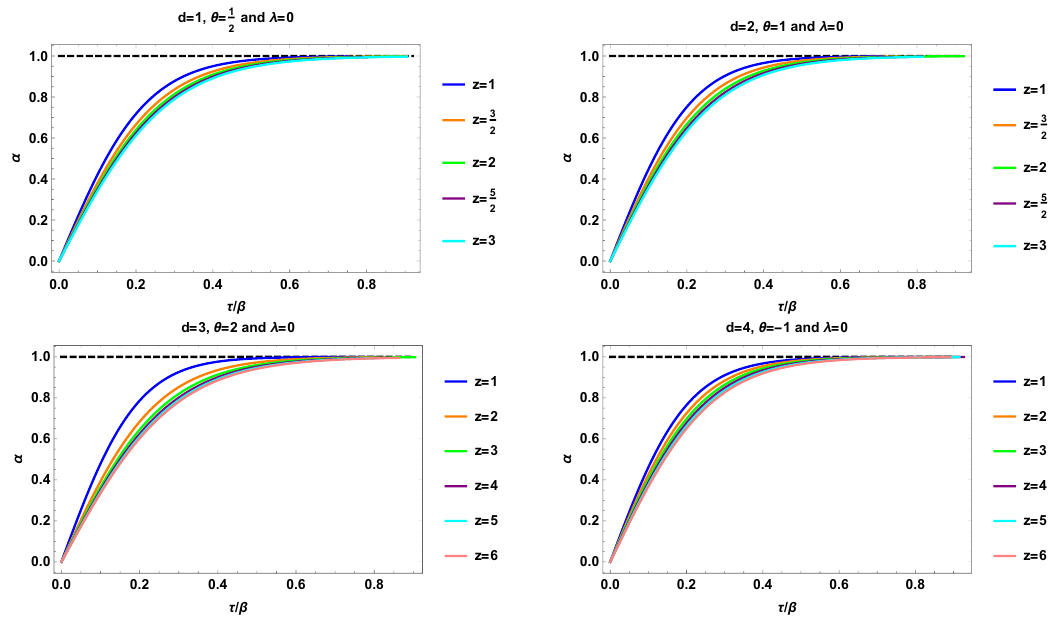
Figure 3 . The normalized growth rate α as a function of τ/β for λ = 0 and different values of d , θ and z : Top Left ) d = 1 and θ = 1 , Top Right ) d = 2 and θ = 1 , Down Left ) d = 3 and θ = 2 , Down 2 Right ) d = 4 and θ = − 1 . We set L = r h = r F = 1